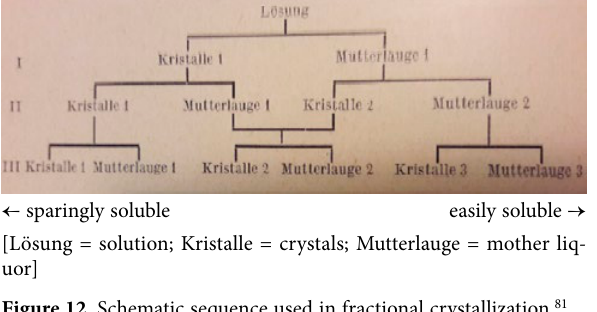
Figure 12. Schematic sequence used in fractional crystallization.